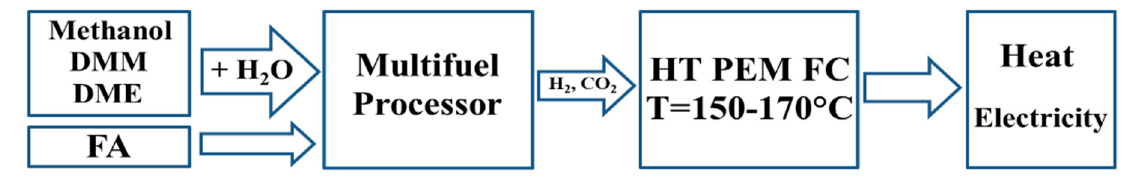
Figure 1. Scheme of power unit based on high temperature proton exchange membrane fuel cells fueled by oxygenates.